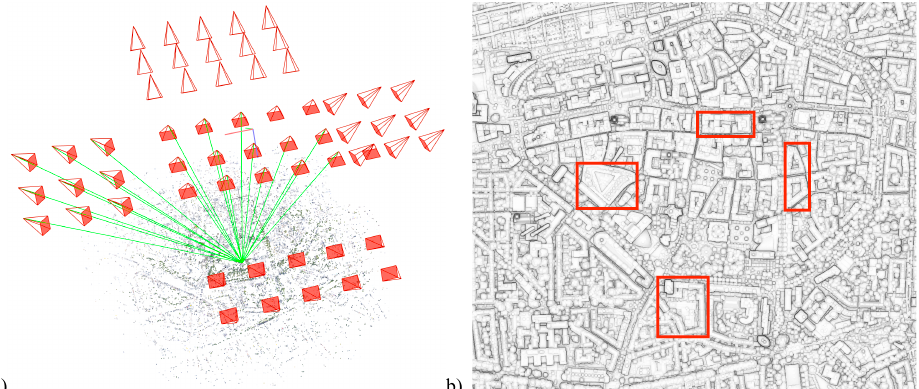
Figure 3: Dortmund dataset - Recovered image network (a) and the available GT LiDAR (area of ca 1.3x1.3 km) with the four chosen built-up areas